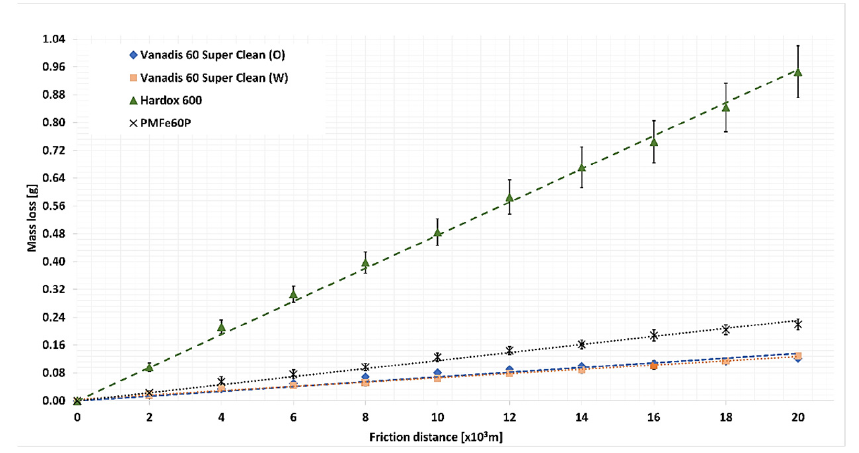
Figure 10. The course of weight loss for the test materials in the medium soil.